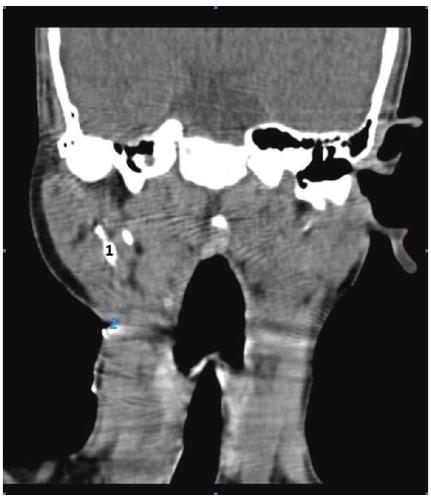
Figure 2: CT fistulogram with coronal reconstruction showing the fistula tract (marked as 1) passing through the deeper part the parotid gland. The cutaneous opening is marked as 2.